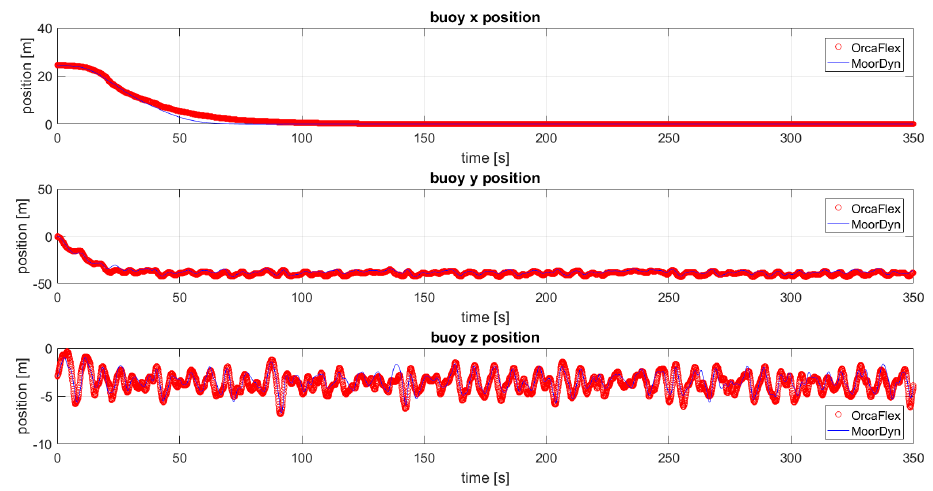
Figure 18. Simulation case 5: Time series of buoy’s position.